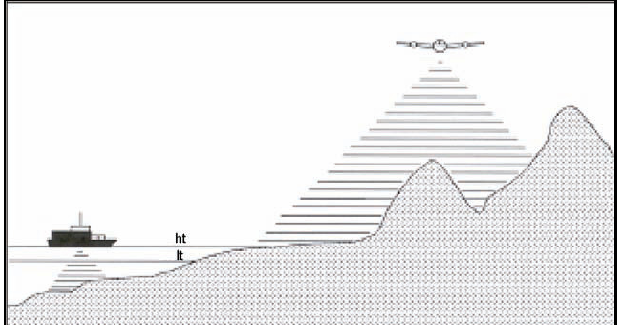
Figure 4. Laser altimetry and sonar bathymetry used to measure beach elevation is used to estimate the volume of sand required to restore the coastal defence function of the beach (Courtesy D. van der Vlag,